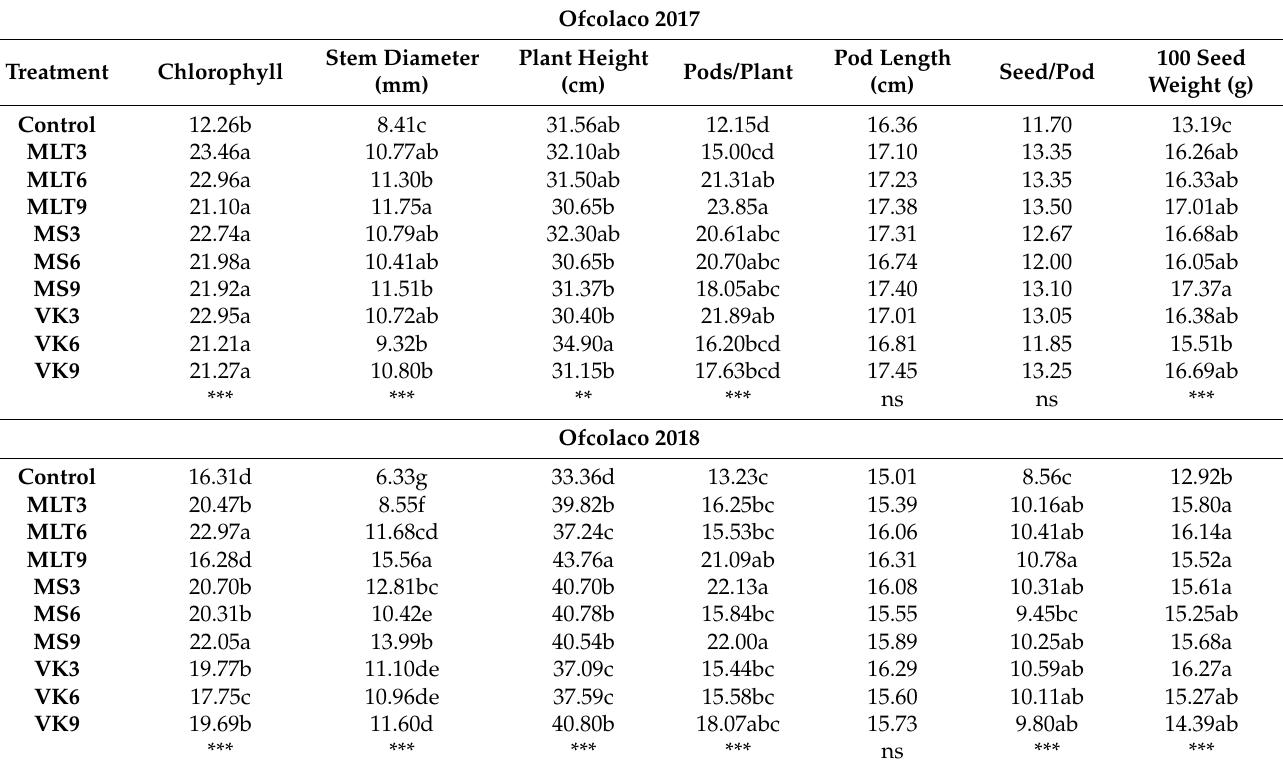
Table 6. Yield determining parameters as influenced by the combined effect of mulch type and rates at